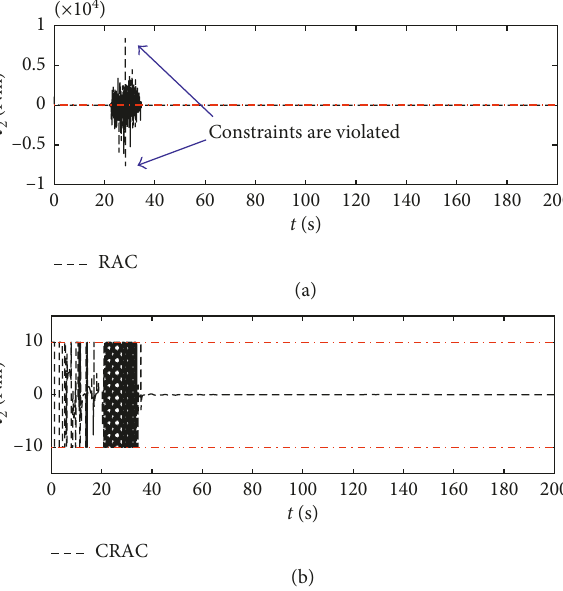
Figure 17: Time response of required control torque u